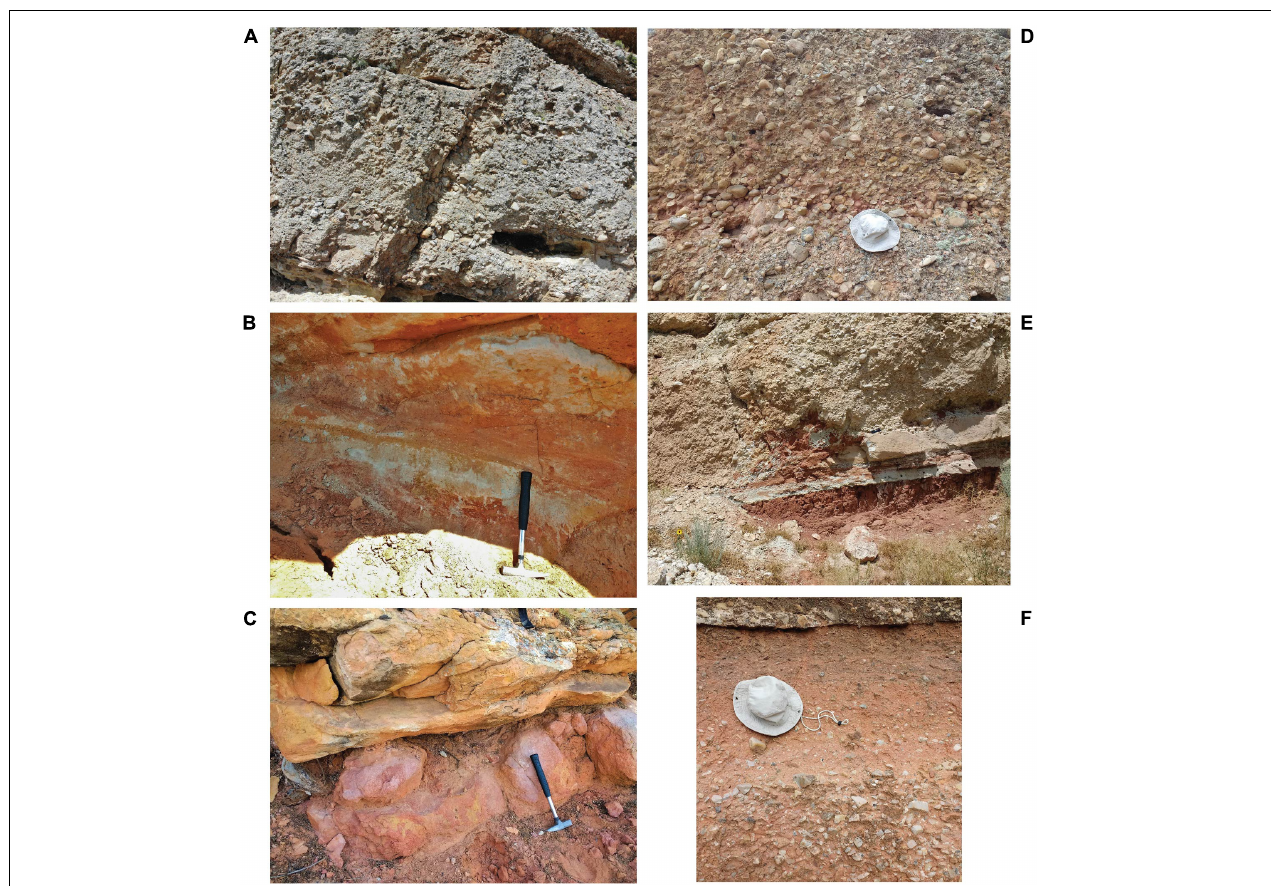
FIGURE 4 | Key facies found in the Richards Mountain Conglomerate (A–C) and Echo Canyon Conglomerate (D–F) . (A) Clast-supported structureless to poorly stratified cobble and boulder conglomerates. Interpreted as channel deposits on a streamflow-dominated alluvial fan. (B) Fine-grained sandstone with mottled red and yellow colors and ripple/trough-cross-stratification or structureless texture. Rhizoliths are abundant (light-colored, linear features near handle of hammer). Interpreted as sandy channel deposits that have undergone early pedogenesis. (C) Fine-grained, structureless mudstones (lower pink bed) with abundant rhizoliths and red and yellow mottling. Interpreted as mature paleosols which frequently cap the conglomerate and sandstone channel complexes that make up the bulk of fifth-order lithosomes. (D) Clast-supported, structureless cobble conglomerates. Interpreted as channel deposits probably emplaced in high-intensity, short-duration flows or possibly as debris flows. (E) Largely, structureless red mudstones with rhizoliths and some mottling of color at bottom of image. Interpreted as paleosols formed on inactive fan segments; frequently scoured away by overlying channel conglomerates (as also seen in this image). (F) Clast-supported, angular pebble to cobble conglomerate grading upward into matrix-supported angular pebble conglomerate. Interpreted as deposits from debris-flows or highly concentrated flows due to matrix-support and highly angular